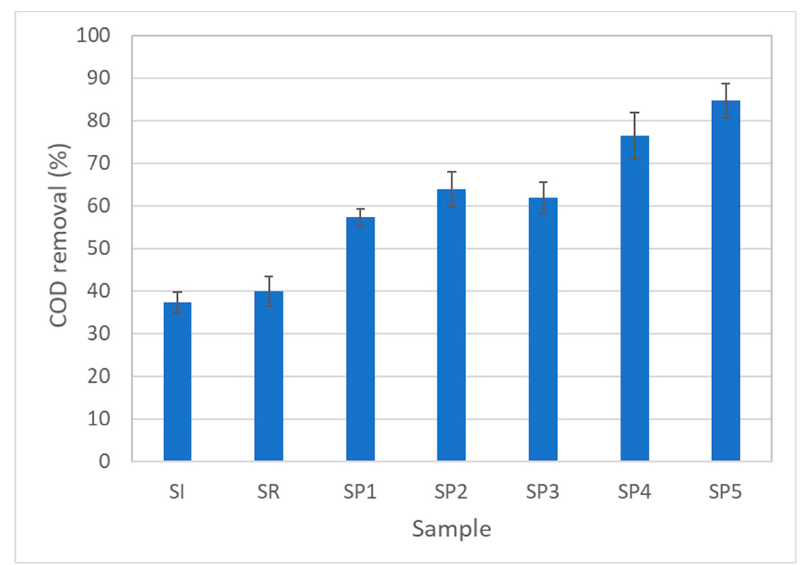
Figure 5. COD removal in the BMP tests.